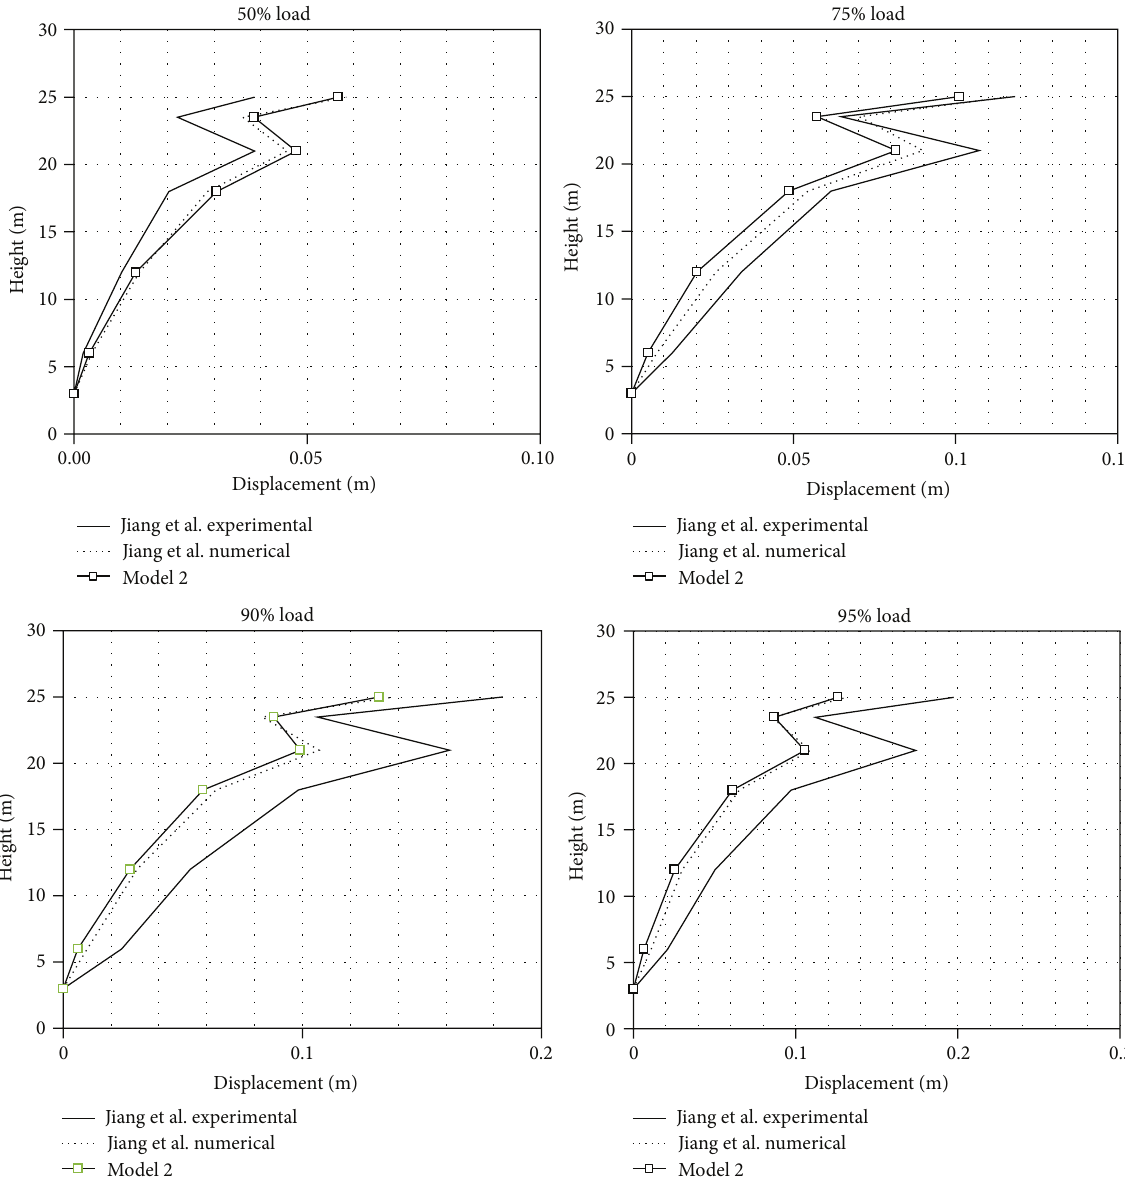
Figure 21: Tower 2 longitudinal displacement at bearing construction